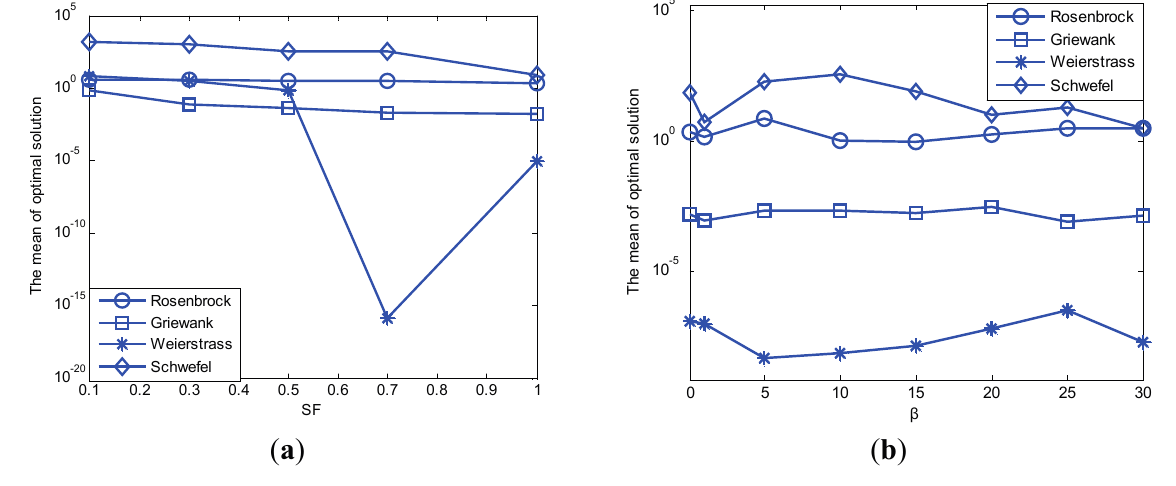
Figure 8. ( a ) Effect of SF on multimodal functions; ( b ) Effect of β on multimodal